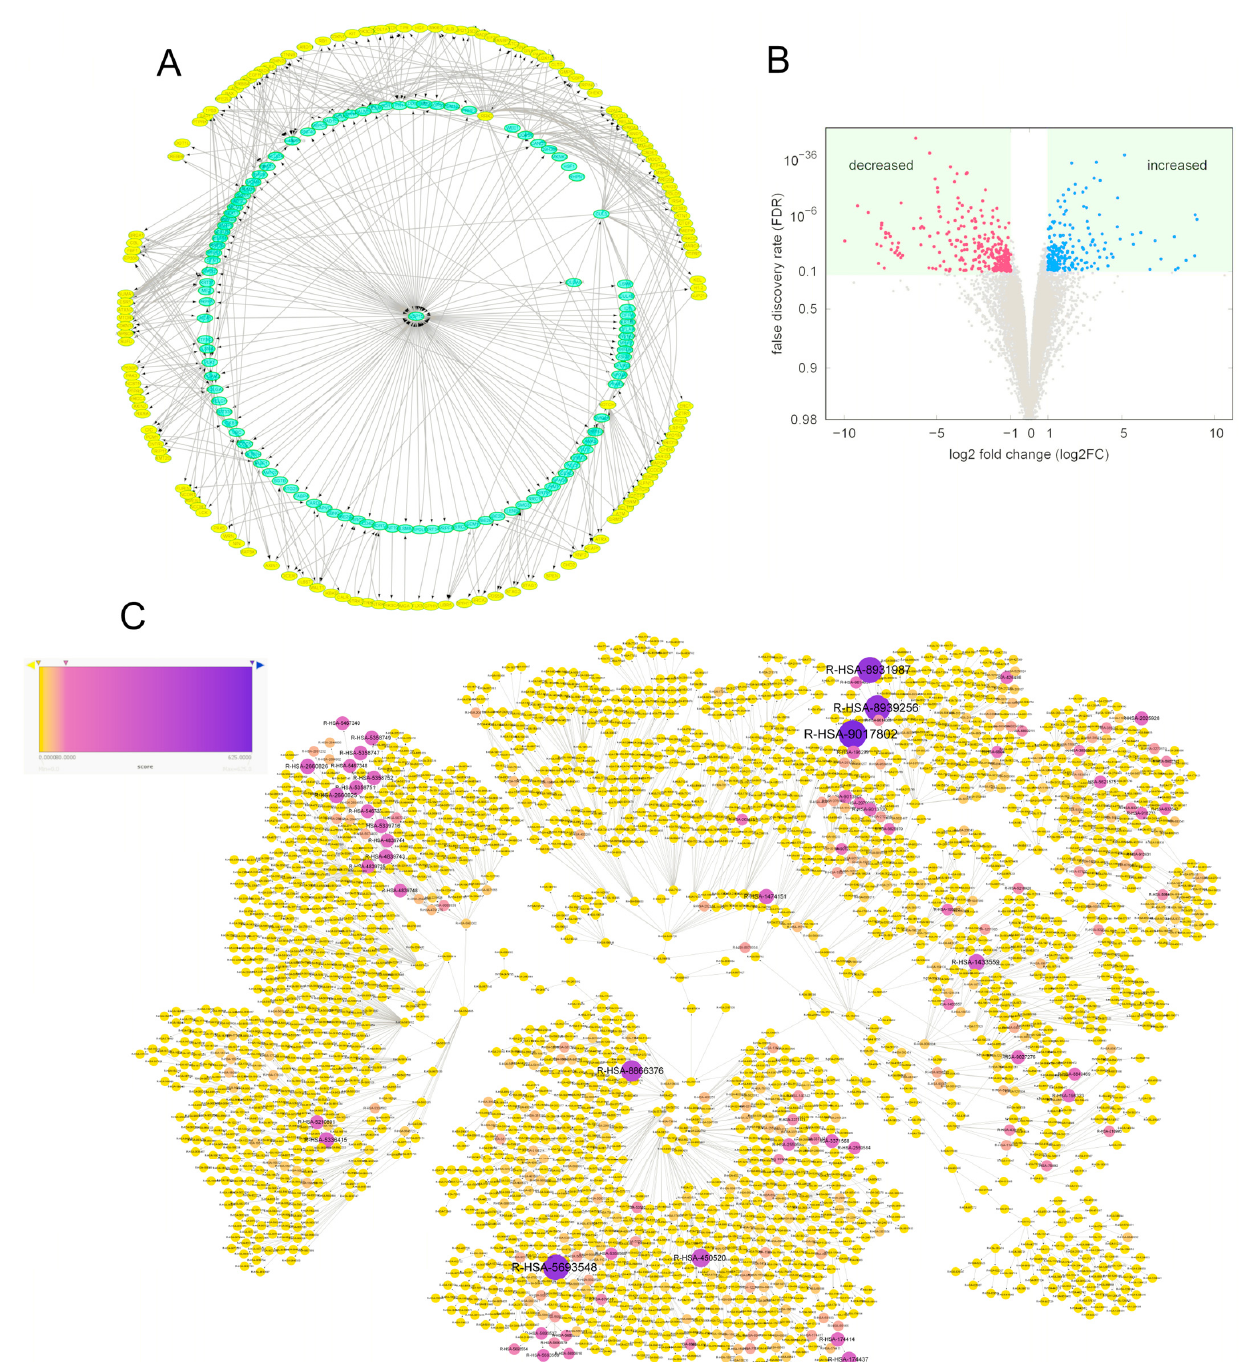
Figure 5. Regulatory role of USP15 in HCC: pathway hierarchies. ( A ) Sub-network of the human USP15 PPI network. A total of 143 liver cancer genes (highlighted in yellow) interact directly or indirectly with USP15. ( B ) Volcano map of the effect of knockout of USP15 in cell line HAT22T. The log-fold change of 14,099 identified genes in cell line HA22T sgUSP15 (knockout USP15) ver- sus cell line HA22T sg-control as control, see material and methods. A fraction of 1.4% (203 pro- teins, highlighted in blue) showed increased expression levels (false discovery rate < 0.1, log-fold change > 1). A fraction of 2.0% (278 proteins, highlighted in red) showed decreased expression (false discovery rate < 0.1, log-fold change < − 1). ( C ). Network of all human pathway hierarchies. Nodes with high score s are highlighted in dark blue and may contribute to the regulatory role of USP15 in HCC, see